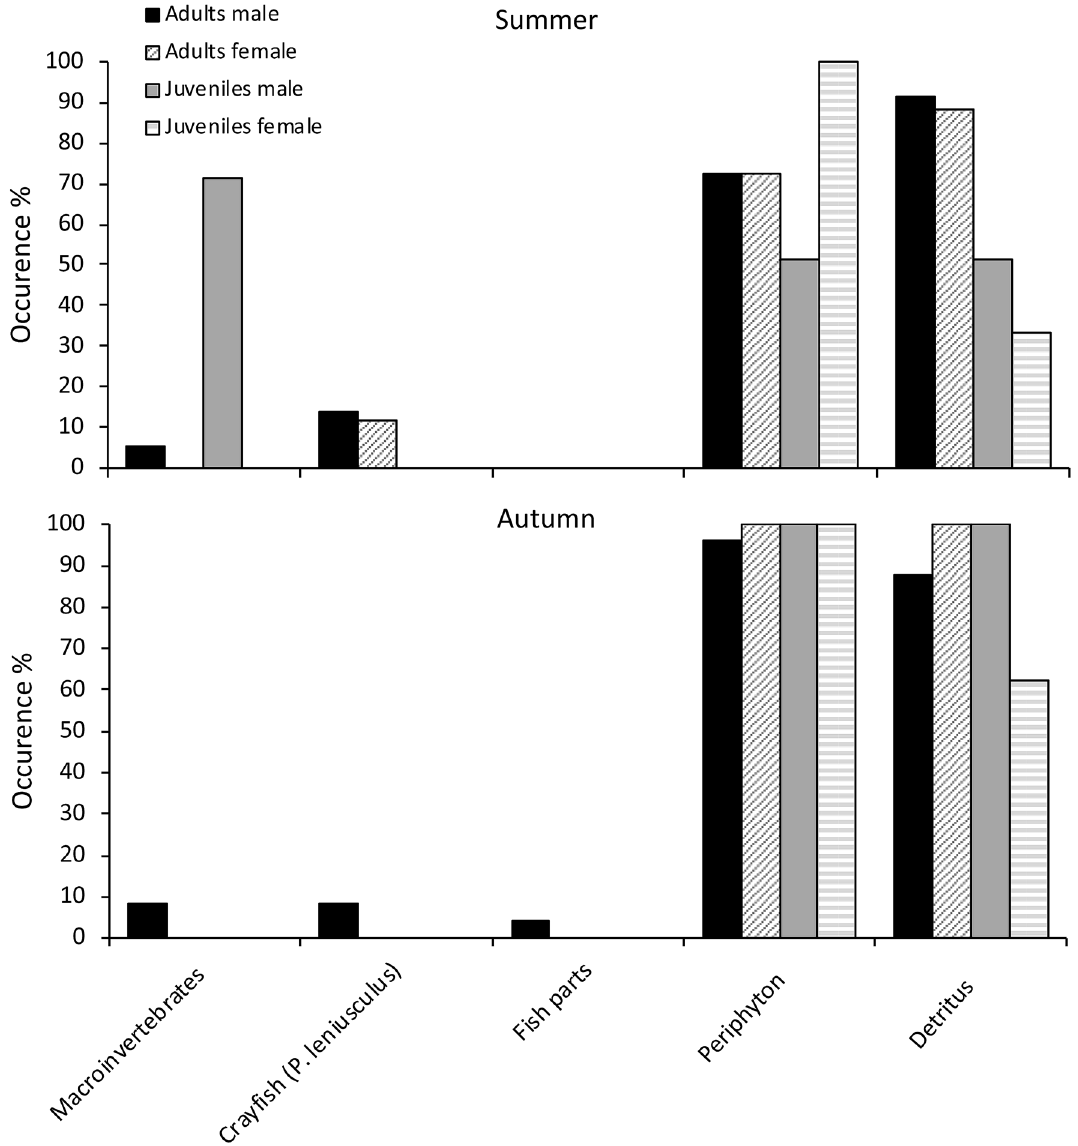
Figure 6. Food item occurrence in stomachs of adult and juvenile crayfish in Valla Stream in summer and